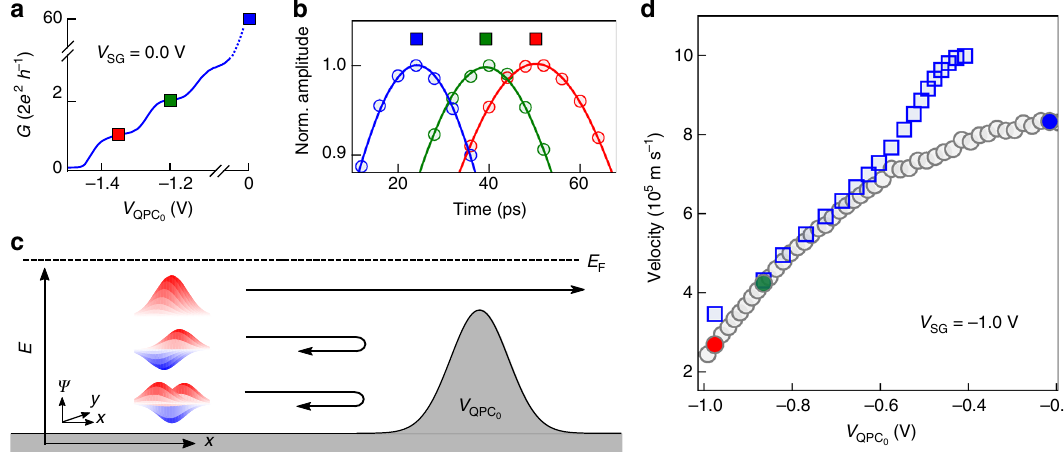
Fig. 3 Channel selection of an electron pulse. a Conductance trace of the channel selection QPC 0 for V SG = 0.0 V. b Time-resolved measurements of the electron pulse propagation detected at QPC 1 position, when QPC 0 is deactivated (blue), or set to a conductance of G = 2 e 2 / h (red) and G = 4 e 2 / h (green). c Schematic of the mode fi ltering experiment. The propagating voltage pulse populates all the available plasmon modes of the quantum wire (here for illustration purposes we show three) before passing through the channel selection QPC 0 . The QPC 0 , which is set to G = 2 e 2 / h re fl ects all channels except the one with the highest kinetic energy. After passing the channel selection QPC 0 , only one single-channel plasmon mode is populated over a propagation distance of 25 μ m. d Propagation velocity of the electron pulse as a function of the channel selection QPC 0 voltage at a fi xed con fi nement potential V SG = − 1.0 V. The grey circles correspond to the experimentally measured velocity at QPC 1 , while the blue squares is the outcome of a parameter-free calculation (c.f. Supplementary Note 4). The coloured circles correspond to the velocity measured for different conductance values of QPC 0 , i.e. G = 2 e 2 / h (red circle), G = 4 e 2 / h (green circle) and fully depolarised QPC V = − 1.0 V 0 (blue circle). These data points correspond to the dotted vertical line in Fig. 2b at SG